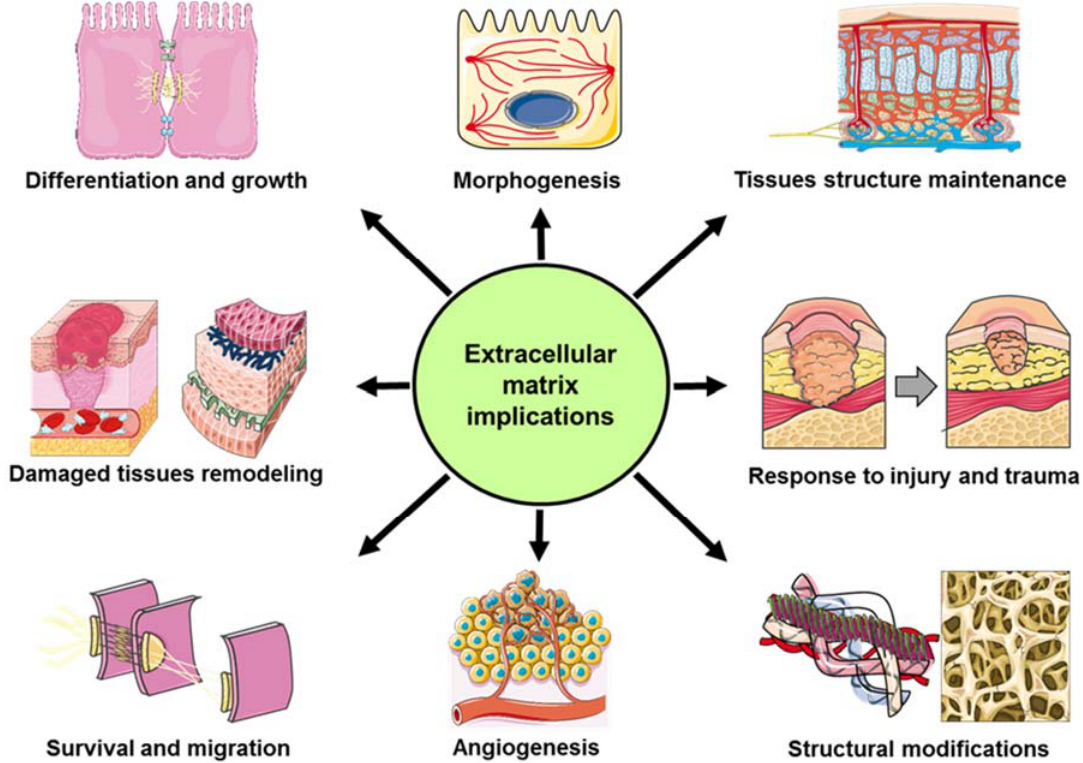
Figure 1. Example of extracellular matrix (ECM) implications. The extracellular matrix is involved in a variety of biological functions, mainly but not only during tissue development under physiological and pathological conditions.